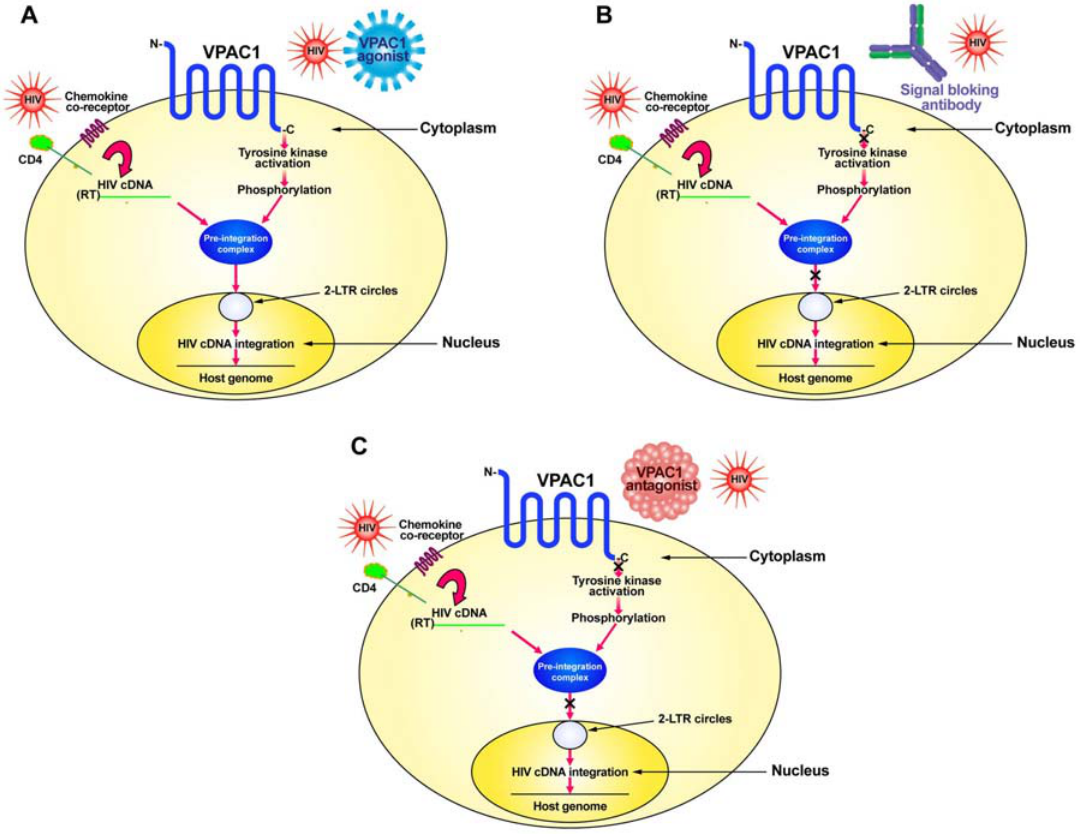
Figure 1. Schematic representation of how HIV infects cells and how VPAC1 therapeutics might work to prevent productive HIV infection. ( A ). Schematic of HIV infection and role of VPAC1; ( B ). Blocking antibody to VPAC1 inhibits the signal transduction and activation of a tyrosine kinase; thus, preventing formation of the pre-integration complex, nuclear transport and integration of the viral cDNA; ( C ). Specific VPAC1 antagonists, either a peptide or small-molecular-weight non-peptide inhibitor, prevent activation of the VPAC1 receptor resulting in inhibition of viral cDNA transport and